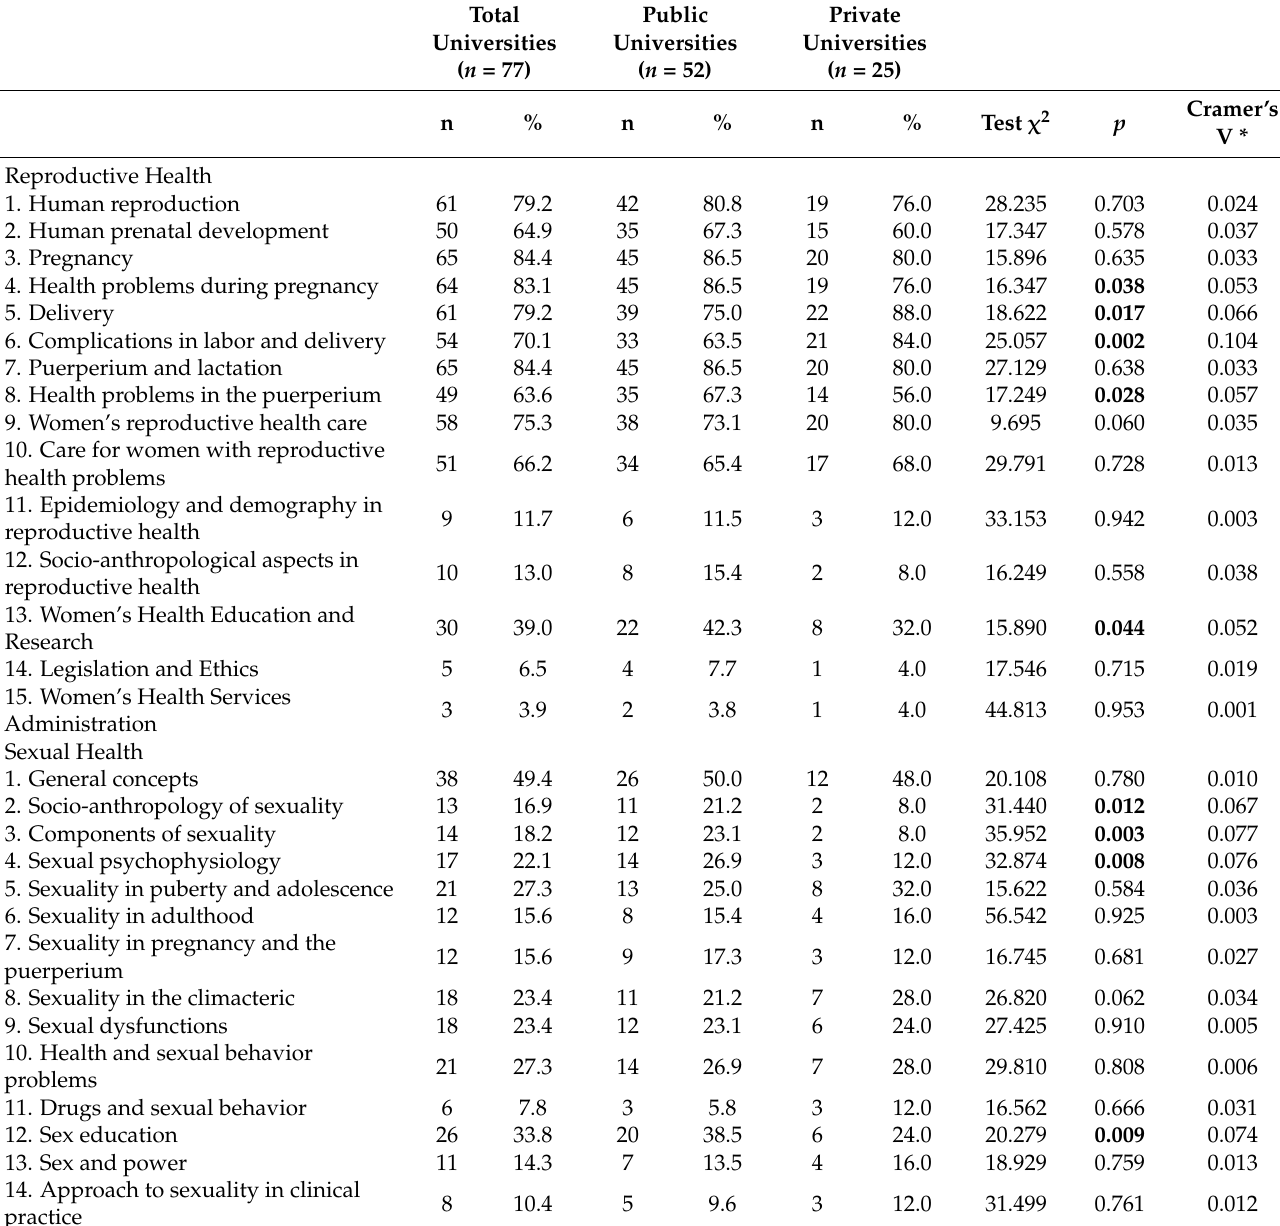
Table 1. Contents of the teaching guides of the Sexual and Reproductive Health subject in the undergraduate nursing curricula of the Spanish